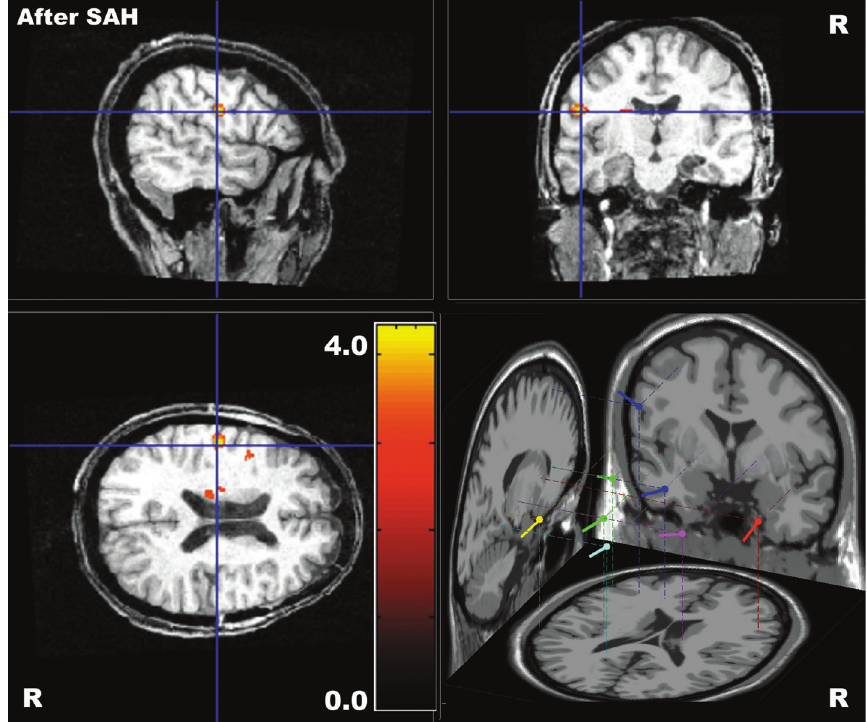
Figure 3. Blood oxygen level- dependent (BOLD) contrast ac- tivation responses associated with all interictal epileptiform discharges recorded after se- lective amygdalohippocampec- tomy (SAH) and coregistered to the patient’s brain structural magnetic resonance imaging. The color bar indicates T-val- ues for positive BOLD re- sponses. In the right lower view of this figure, dipoles to inde- pendent component analysis (ICA) are shown in the Montreal Neurological Institute standard brain, with left-sided predomi- nance. Each dipole color indi- cates an individual